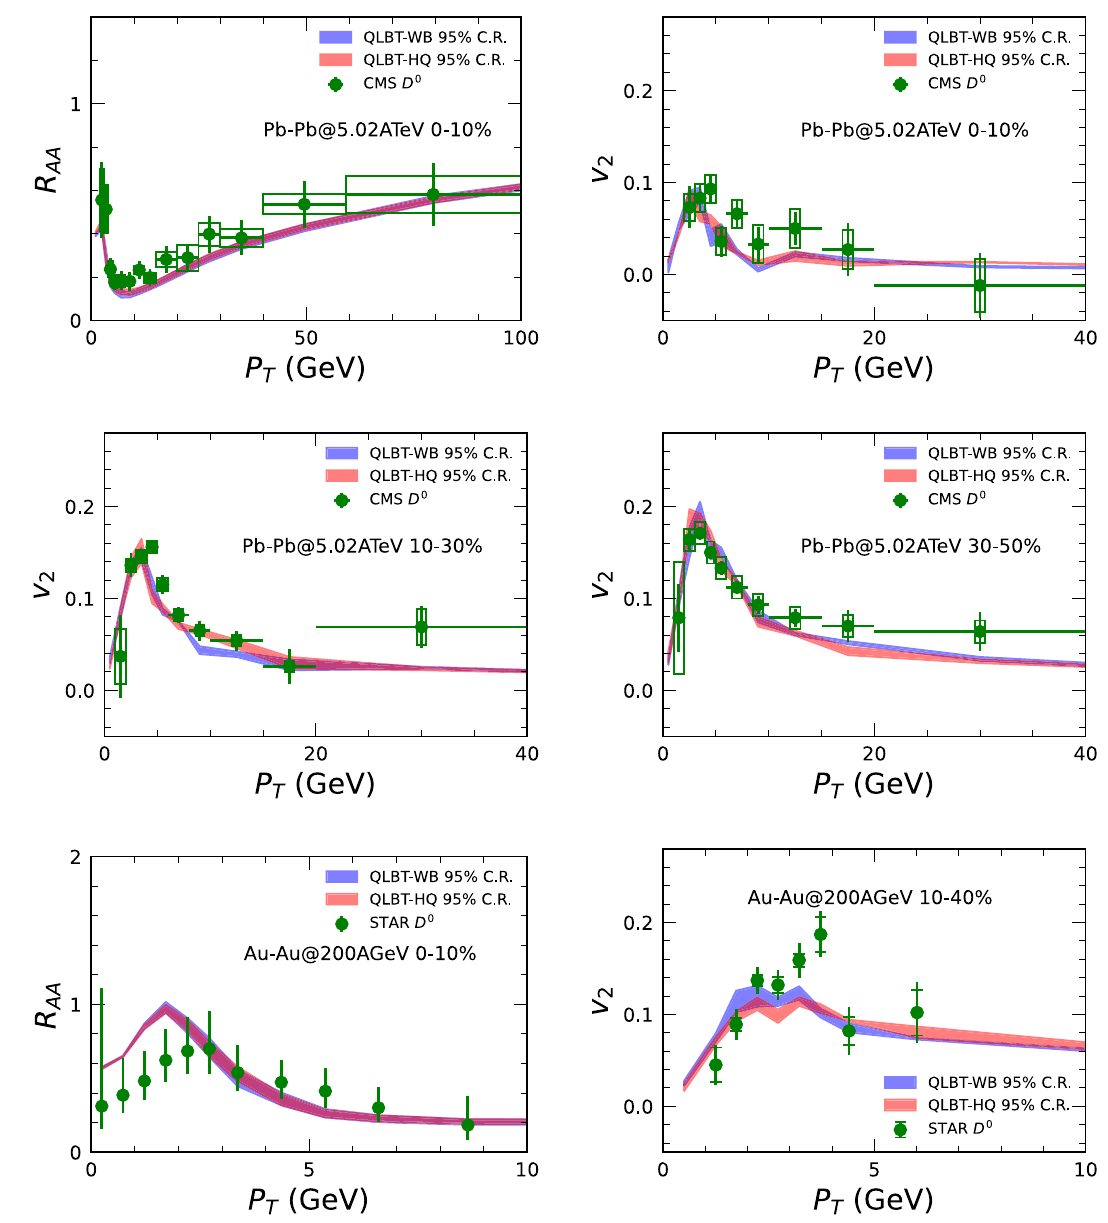
Fig. 5 Using the Bayesian analysis, the nuclear modification factors R AA andtheellipticflow v 2 for D mesonsinPb-Pbcollisionsat 5 . 02 TeV at the LHC and in Au-Au collisions at